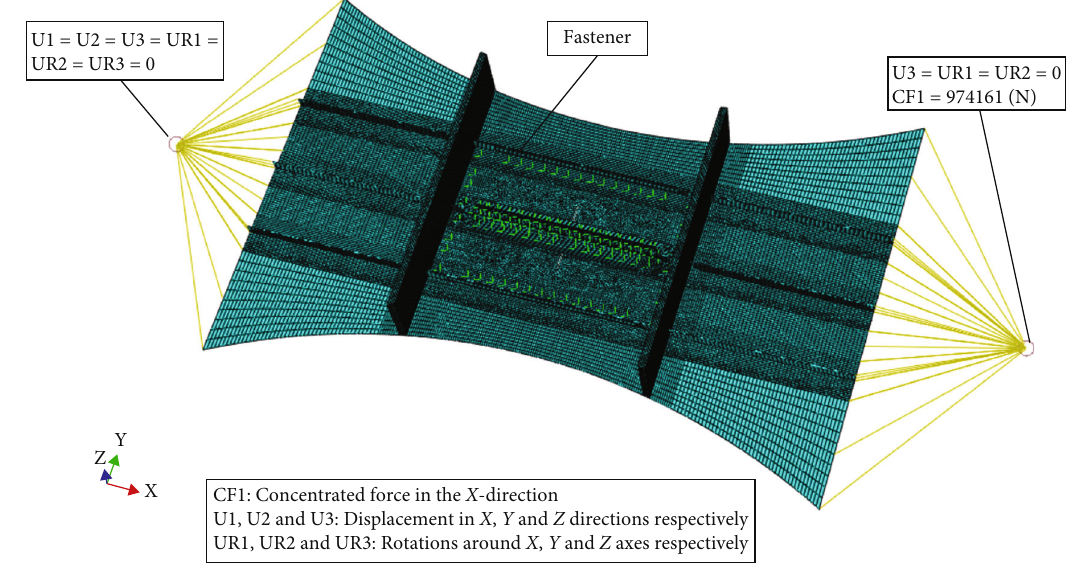
Figure 7: Repaired panel ’ s boundary conditions and fastener